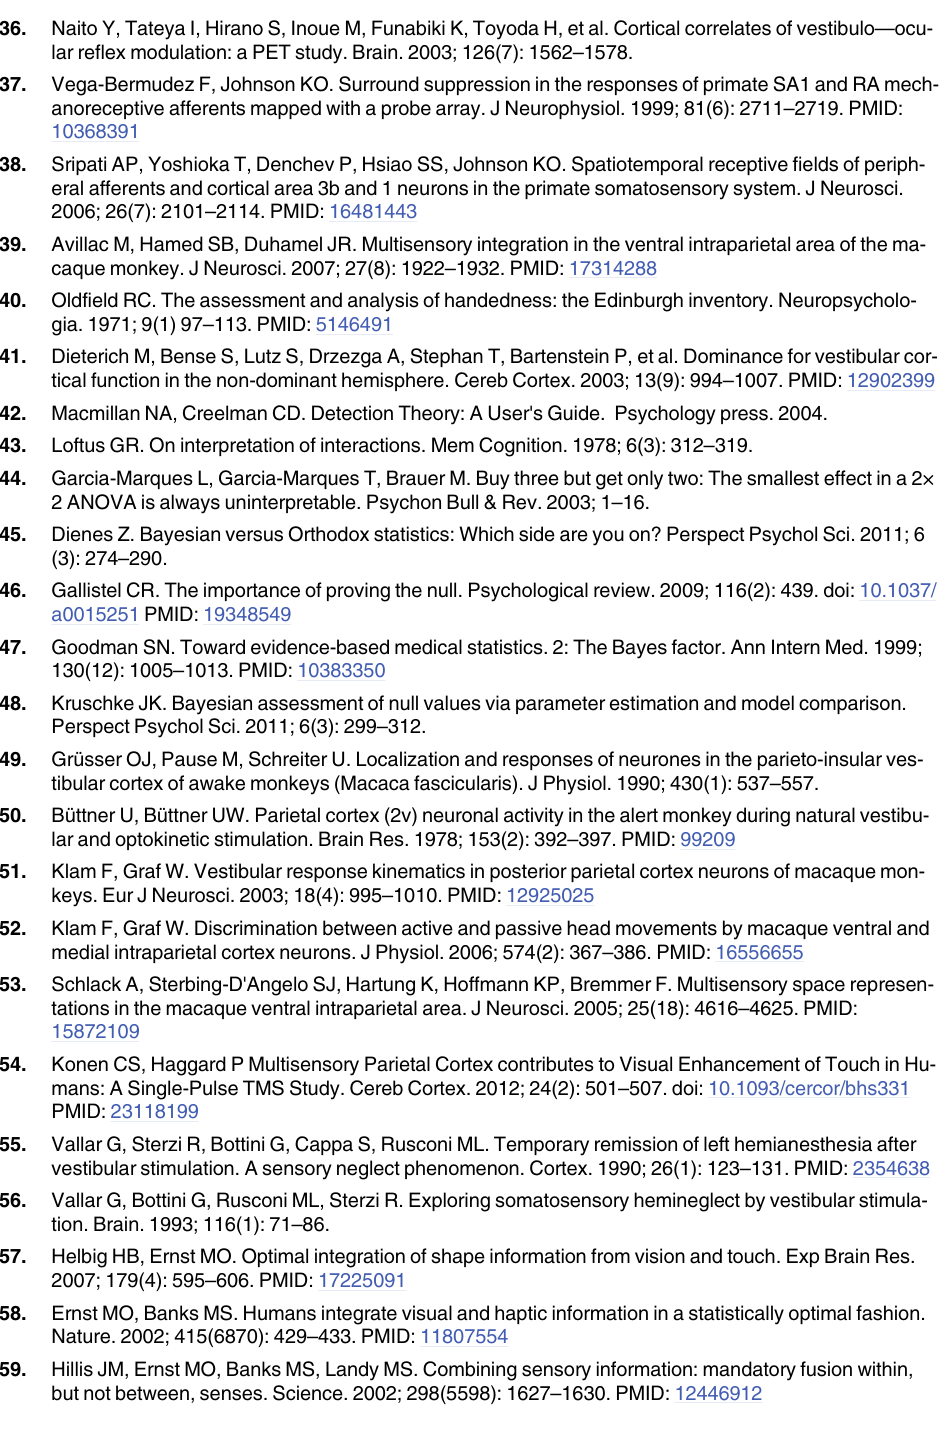
PLOS ONE | DOI:10.1371/journal.pone.0124573 April 13,